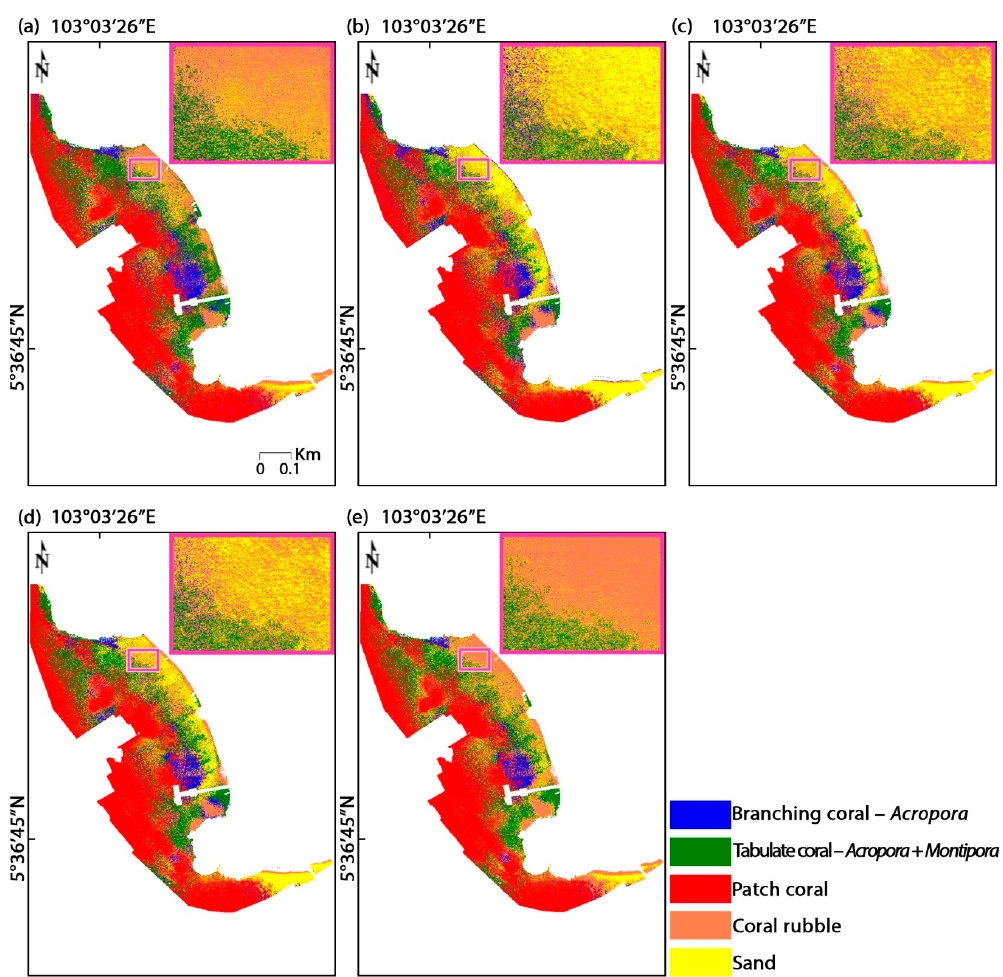
Figure 8. Benthic habitat classification maps of Site-2 (Pantai Vietnam) produced by supervised SVM classification of UAV data. Strategy-2 was used to pre-process data. ( a ) Uncorrected image; images corrected using the methods proposed by ( b ) Lyzenga et al. [35], ( c ) Joyce [47], ( d ) Hedley et al. [28], and ( e ) Goodman et al. [29].